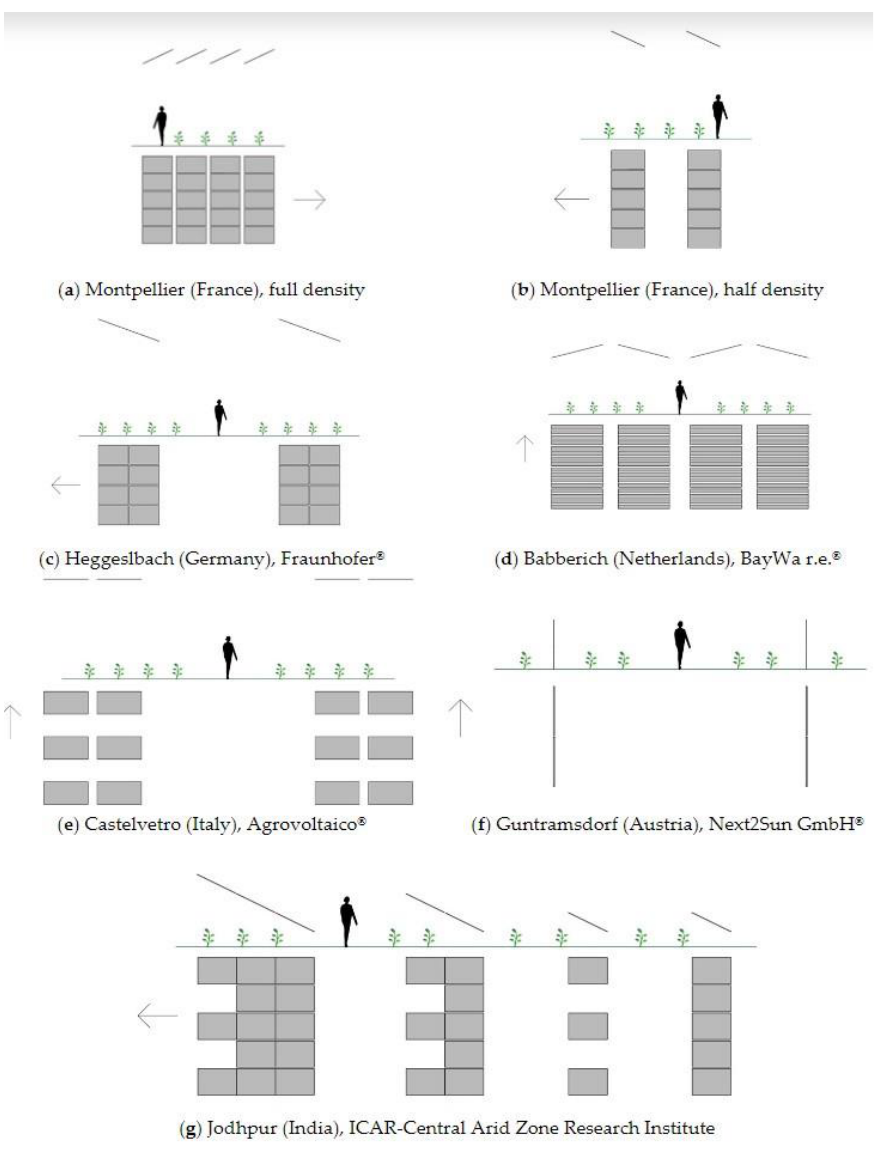
Figure 5. Different array patterns were studied in situ. Source: [43].